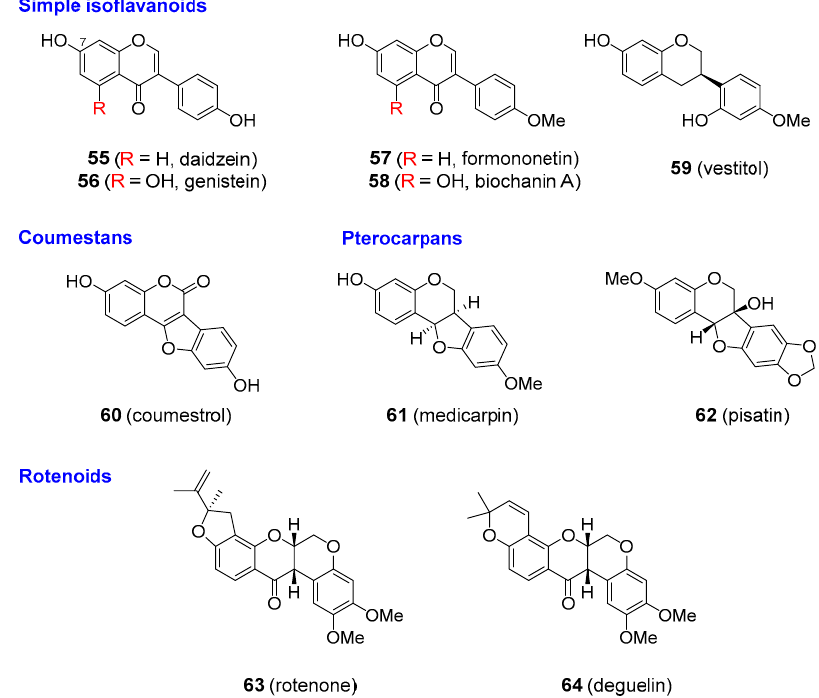
Figure 14. Isoflavonoids of common and more restricted distribution. Molecules 2020 , 25 , x FOR PEER REVIEW